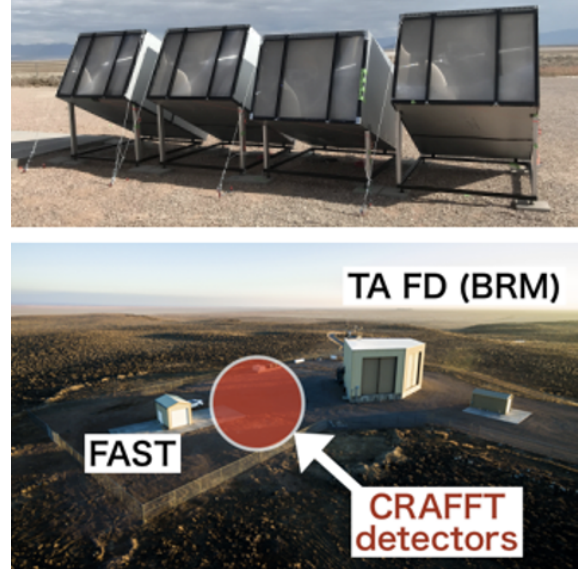
Figure 5. Upper: Four CRAFFT detectors deployed at TA FD Black Rock Mesa (BRM) site. Lower: The location of CRAFFT detectors. CRAFFT detectors are arranged between TA FD sta- tion and the hut of FAST experiment